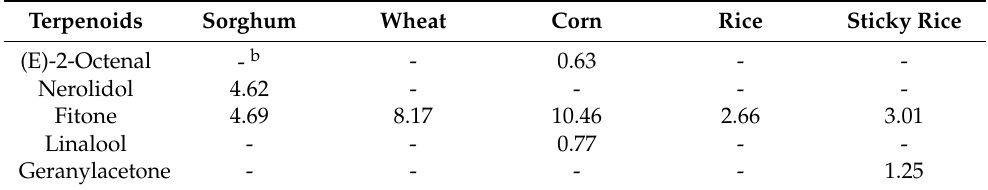
Table 2. Content of terpenoids in blank raw material medium a . Terpenoids Sorghum